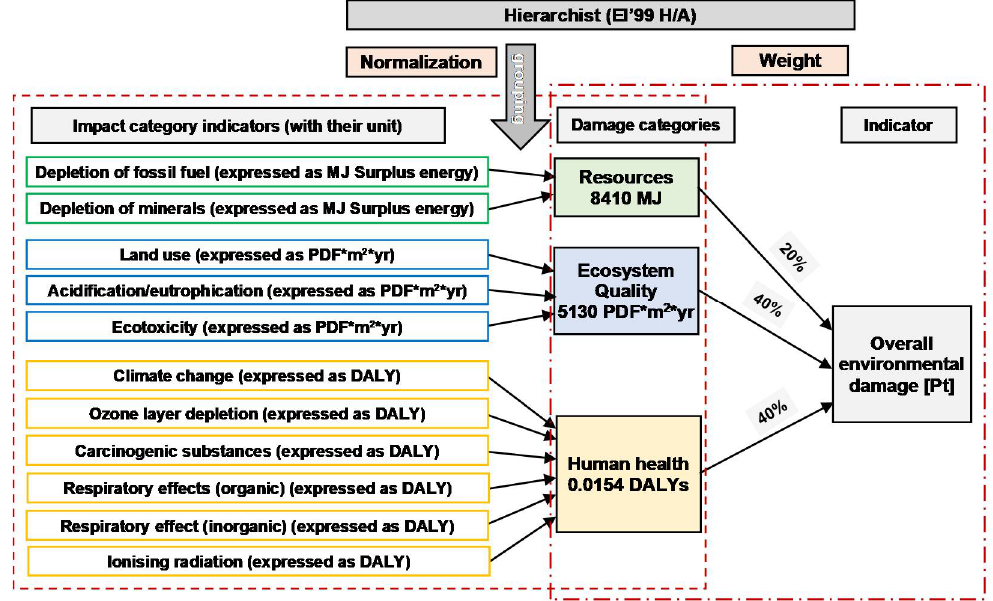
Figure 3. Normalization and weighting factors for the Hierachist (EI’99 H/A) perspectives on the Eco-indicator 99 method.